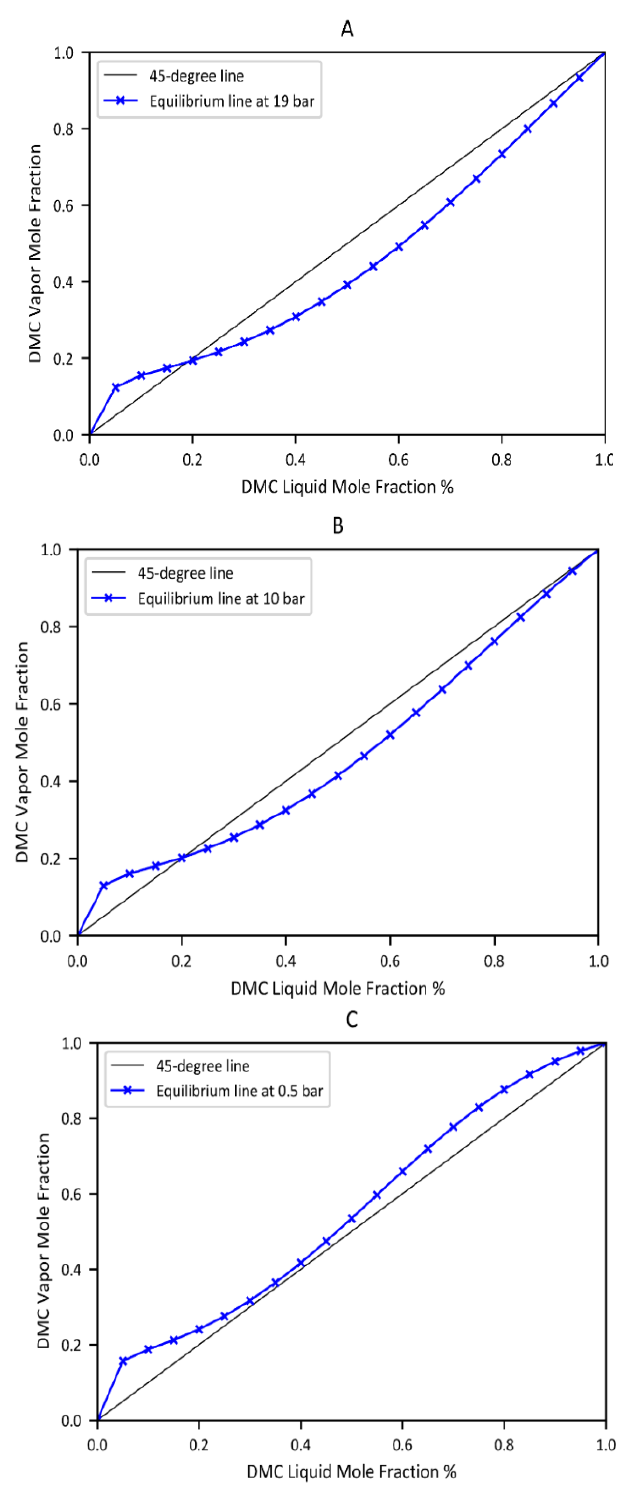
Figure 7. VLE curves of DMC with H 2 O at constant pressures, obtained using the UNIFAC model. ( A – C ) presents the equilibrium at 19, 10, and 0.5 bar, respectively. Table 3. Stream information of the DMC and DMO coproduction process.